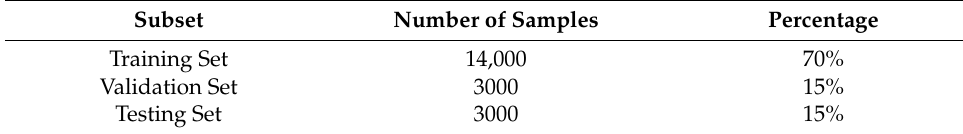
Table 3. Sample numbers and percentages of three subsets in our